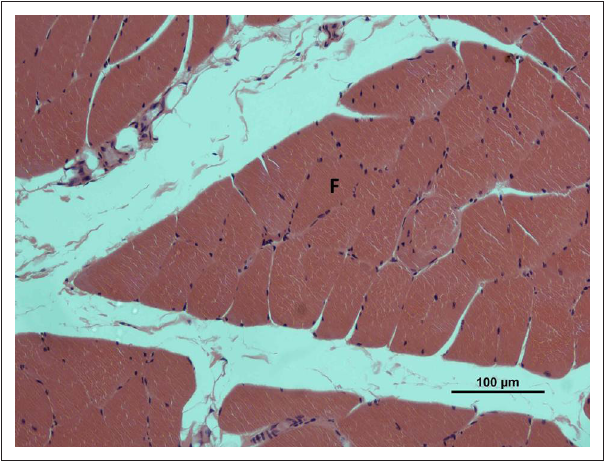
F, myofibres. FIGURE 3 : Haematoxylin and eosin-stained section showing normal cross- sectioned myofibres in normal rabbit skeletal muscle.